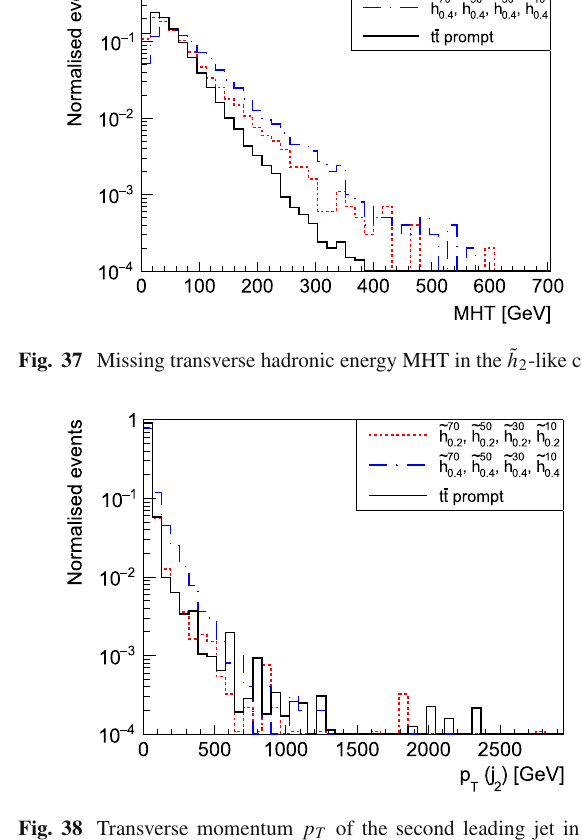
Fig. 38 Transverse momentum p T of the second leading jet in the ˜ h 2 -like